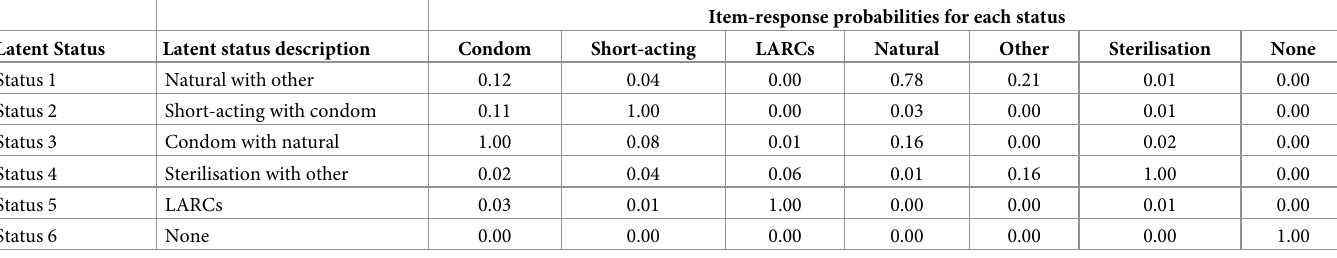
Table 2. Item-response probabilities for the selected optimal six-status